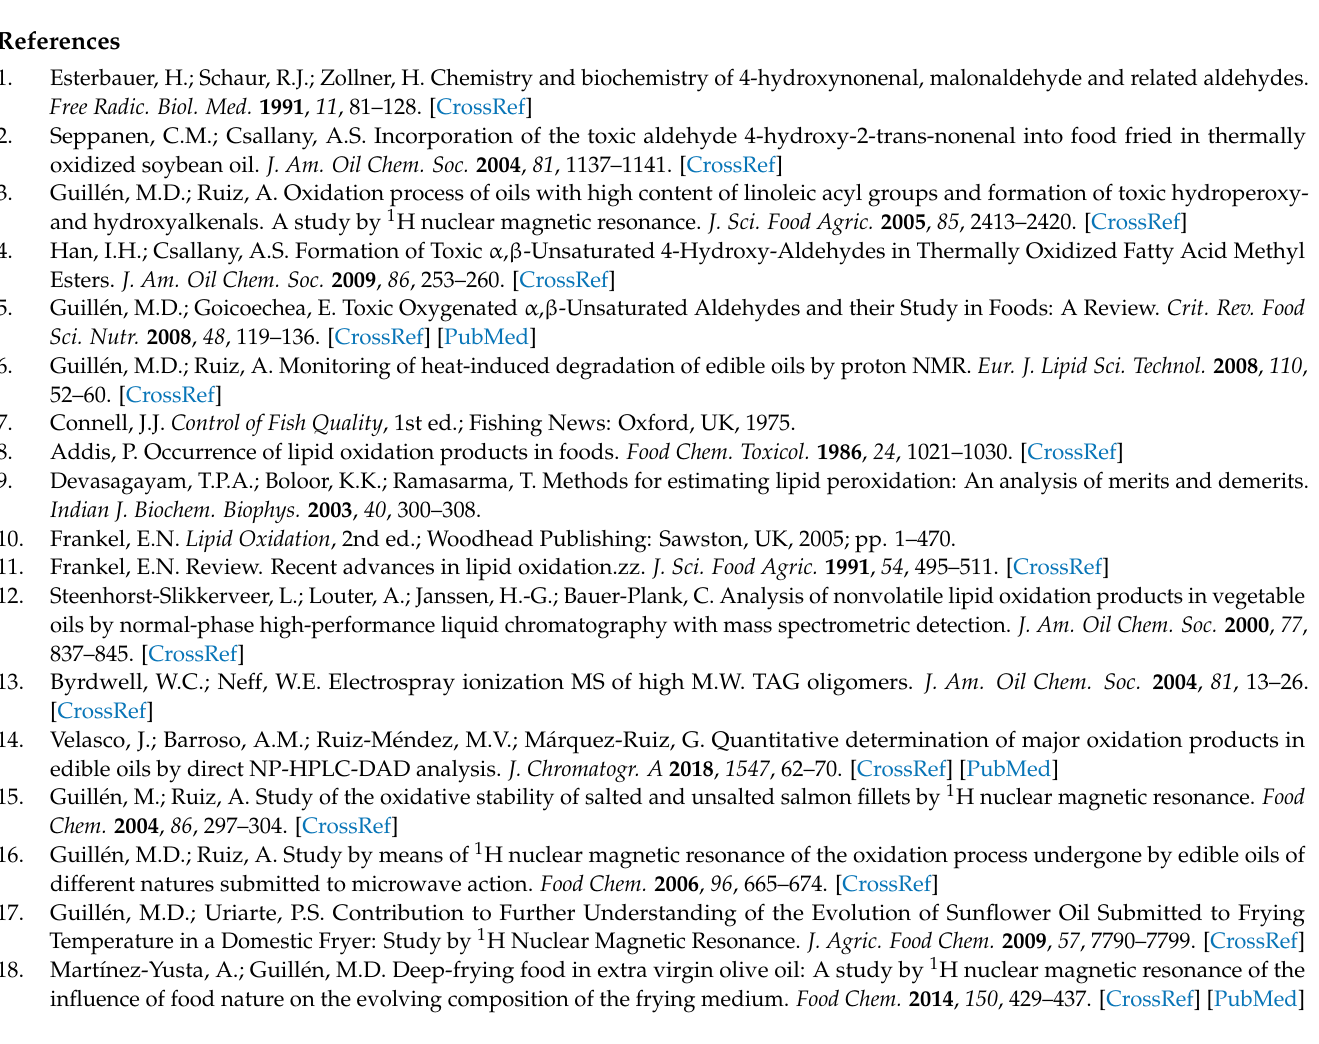
Table S15: Chemical shift assignments and multiplicities of 1 H NMR signals in CDCl 3 of protons of formats; Table S16: Chemical shift assignments and multiplicities of 1 H NMR signals in CDCl 3 of protons of